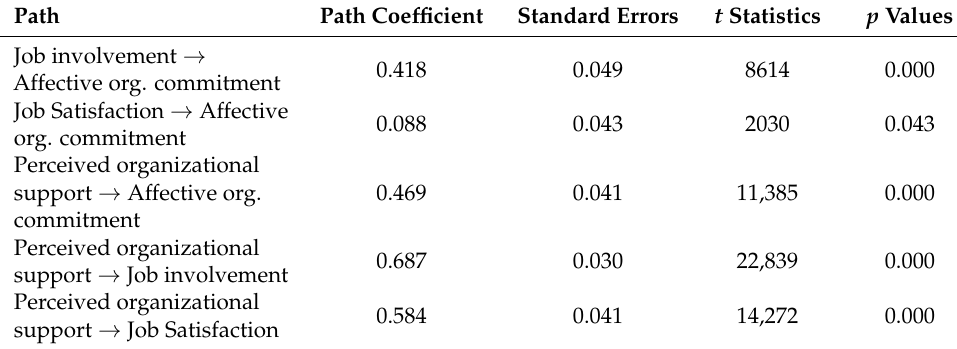
Table 2. Structural model assessment.